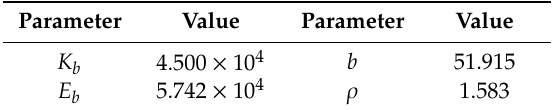
Table 2. Fitted parameters of the self-built secondary nucleation rate model.